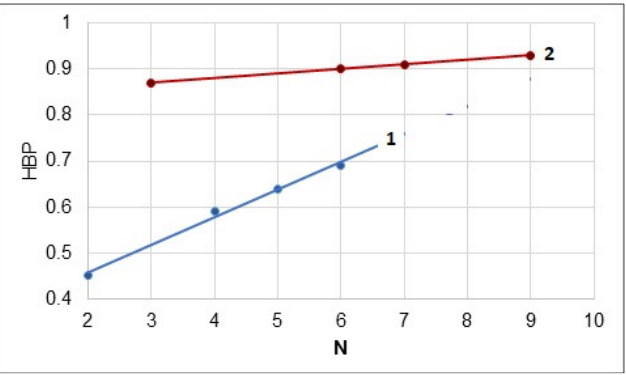
Figure 6. Dependence of hydrophobicity parameter on total number of non-polar groups in repeating unit of cellulose di–( 1 ) and tri–( 2 ) esters.